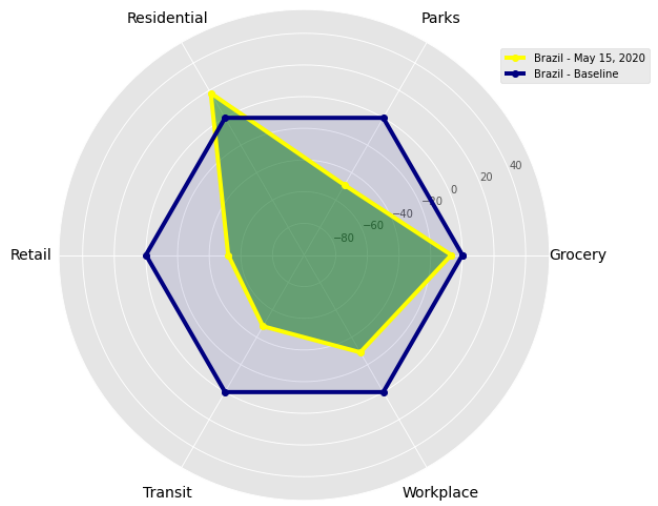
Figure 2. Calculation of the mobility index area on a radar chart. Source of primary data: Covid-19 Community Mobility Reports,